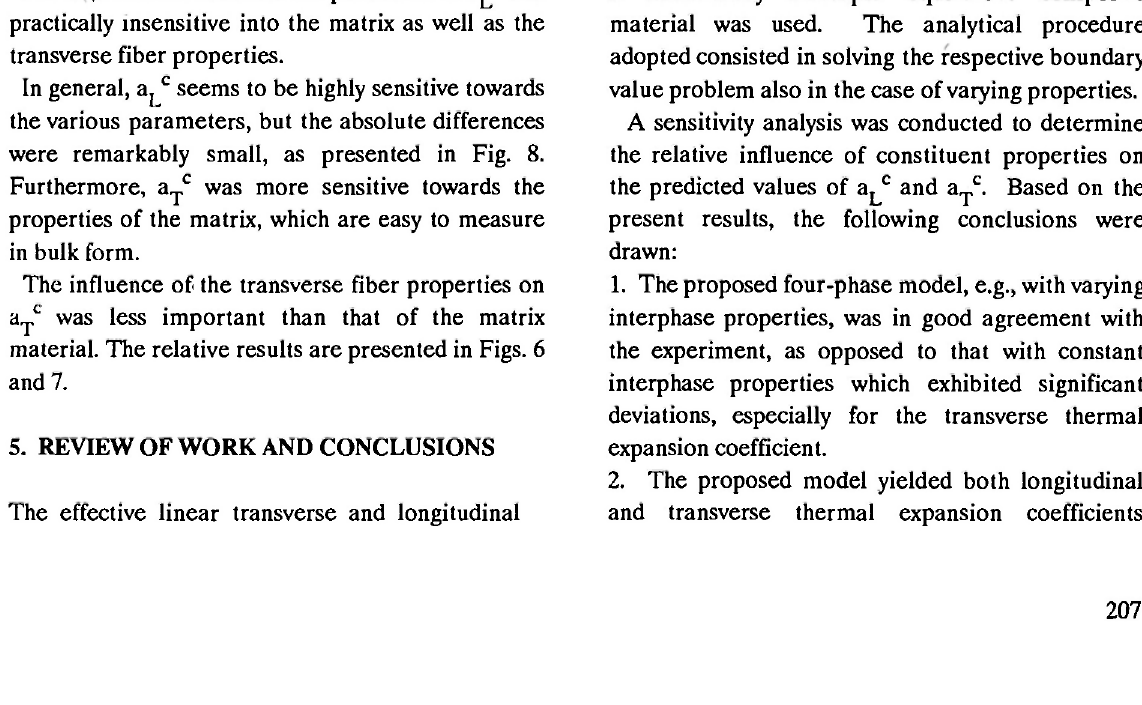
Fig. 9: Variation of the longitudinal thermal expansion coefficient for the proposed four-phase model. e thermal expansion coefficients of a unidirectional a L , e.g. the easiest and most reliable to measure. fiber composite with an interphase were determined Another important parameter affecting the a. c is the f analytically. A four-phase micromechanical model transverse Poisson's ratio of the fiber ν , a quantity consisting of a transversely isotropic cylindrical not easy to measure. elastic inclusion, surrounded by an isotropic linearly elastic cylindrical shell with radia'iy varying elastic and thermal properties, surrounded by a second cylindrical shell of matrix material and embedded